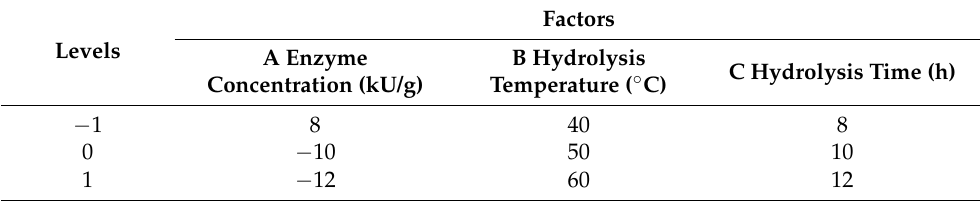
Table 2. Levels and factors of the response